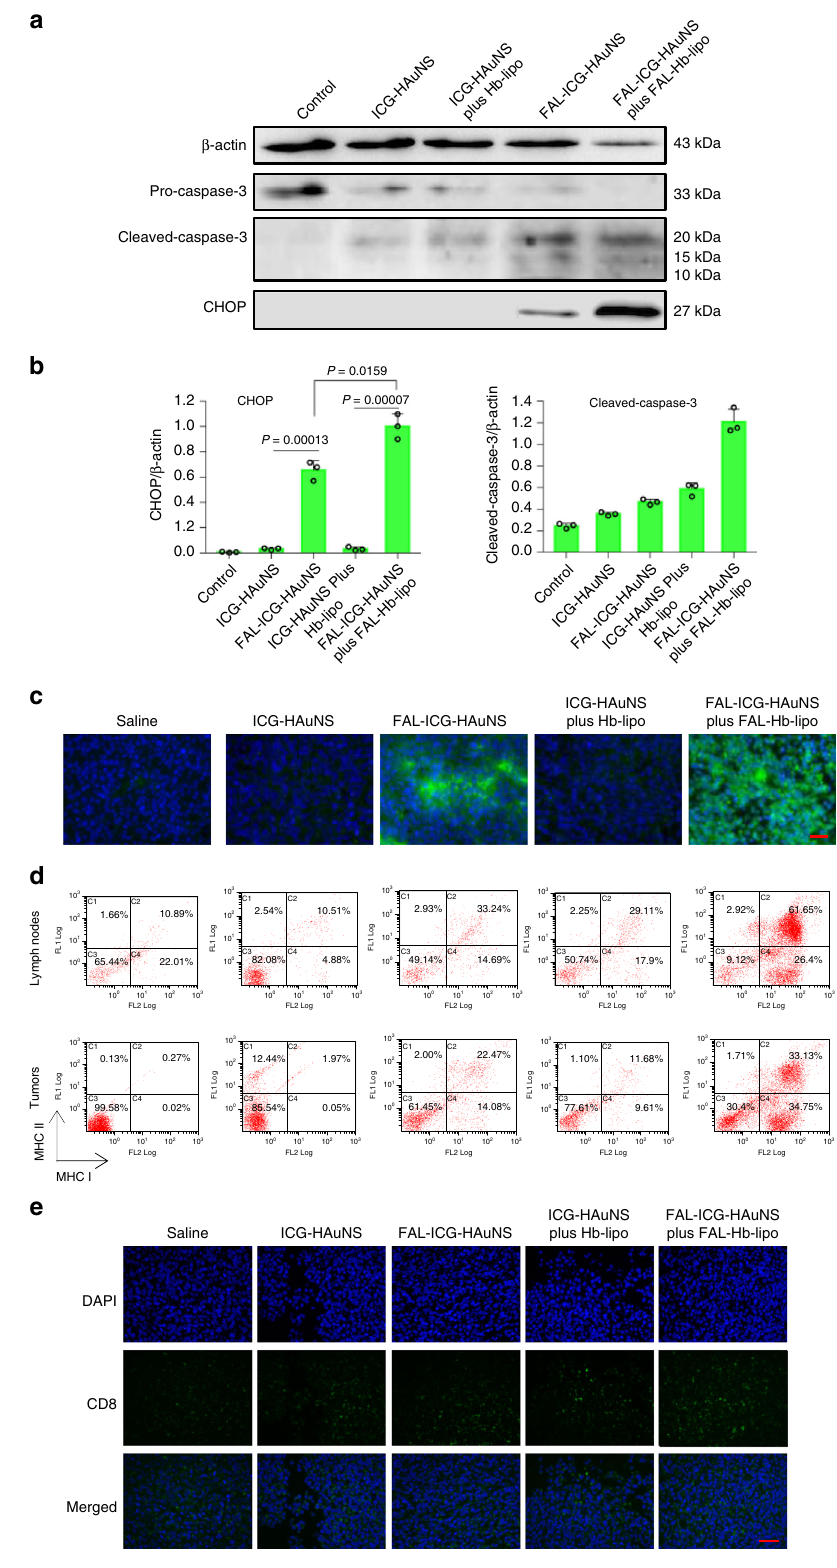
Fig. 6 Immunogenic cell death induced by speci fi c endoplasmic reticulum stress in CT-26 tumor model. Laser power: 1 W/cm 2 , 2 min. a Western blot analysis of caspase-3 and CHOP (C/EBP-homologous protein-10) proteins expressed in CT-26 tumors after drug administration and laser irradiation, n = 3. b Quanti fi cation of cleaved caspase-3 and CHOP proteins normalized by β -actin, respectively. c Representative fl uorescent images of calreticulin expression in CT-26 tumor slices. Scale bars, 50 μ m, n = 3. d Representative images of dendritic cell maturation in tumors and lymph nodes analyzed with fl ow cytometry, n = 3. e Representative fl uorescent images of CD8 makers in tumor slices after different treatments. Scale bars, 50 μ m, n = 3. All data were analyzed with one-way analysis of variance test. All error bars are expressed as ±SD NATURE COMMUNICATIONS| (2019) 10:3349